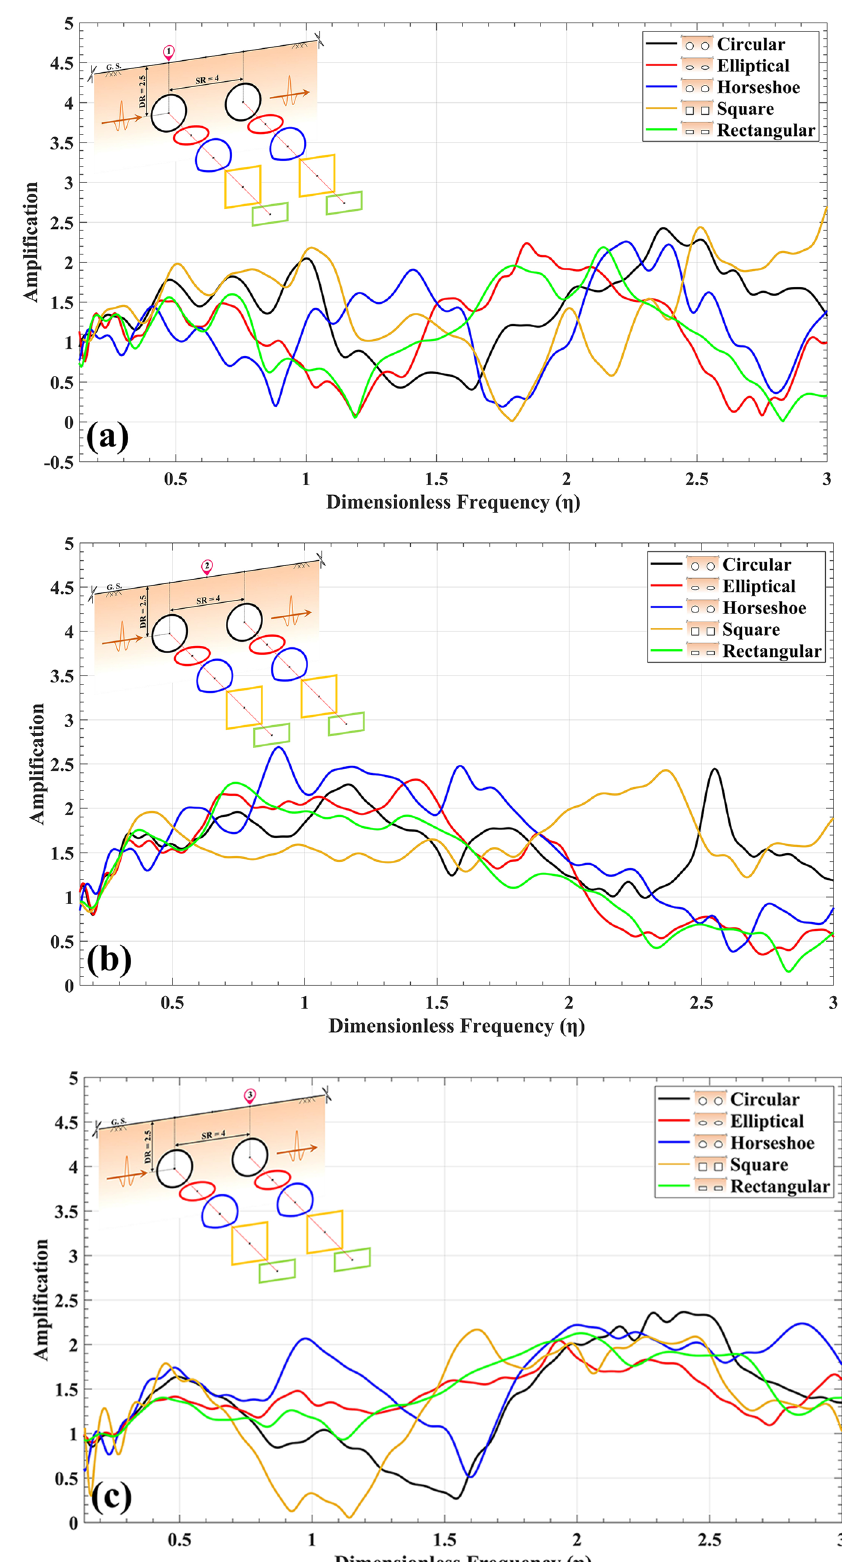
Fig. 14 The amplification of the ground surface versus dif- ferent dimensionless frequen- cies, for the model of twin lined tunnels with different geometries in a centerline of the first tunnel, b central point, c centerline of the second tun- nel subjected to the horizontal incident SH